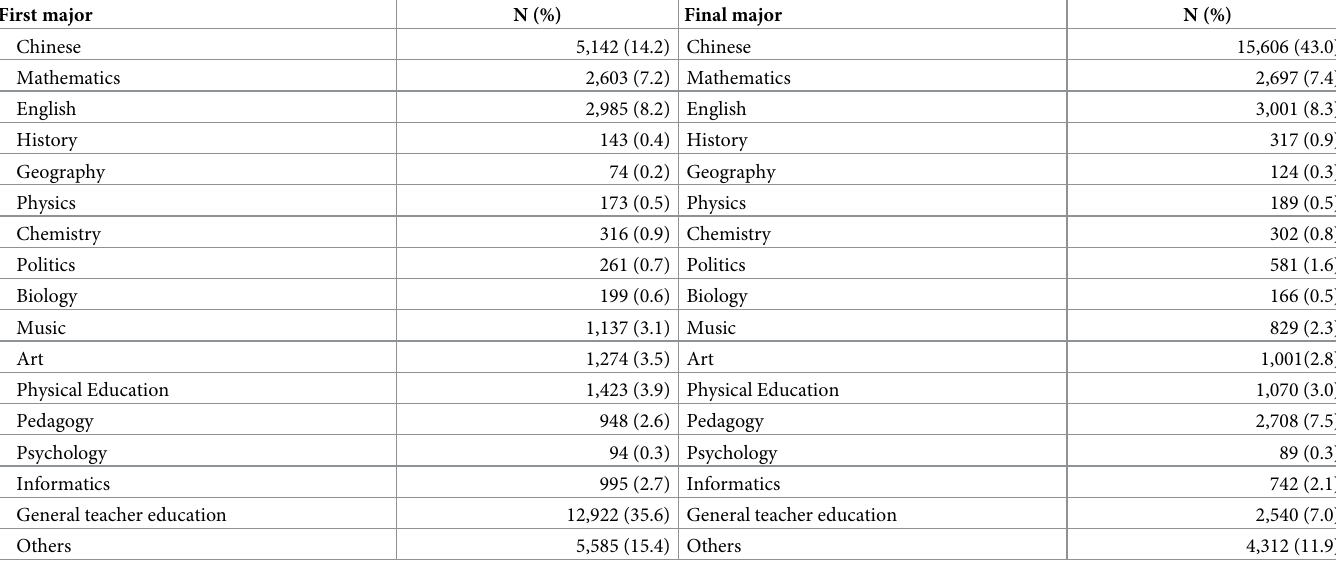
Table 7. Distribution of first and final major of the